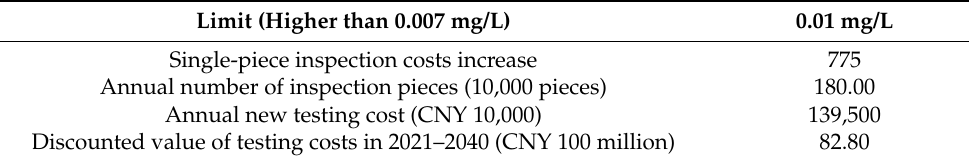
Table 10. Increased government testing costs under the “change